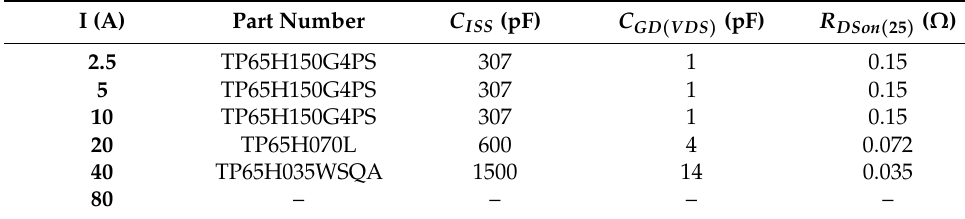
Table 5. Characteristics of selected GaN MOSFETs.